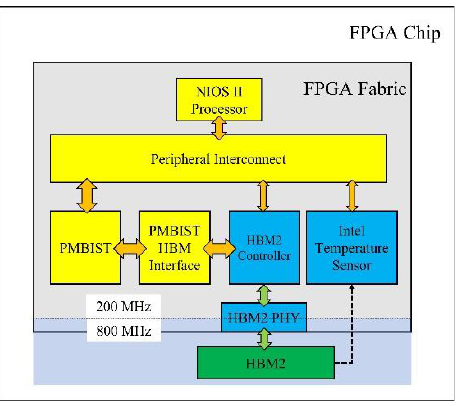
Figure 2. Four major test logic sub-blocks in FPGA; NIOS II processor, peripheral interconnect, PMBIST, and PMBIST – HBM interface.